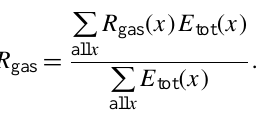
we note that the uncertainty in the ethane ratios is very high for both populations (7.5 and 13 %,